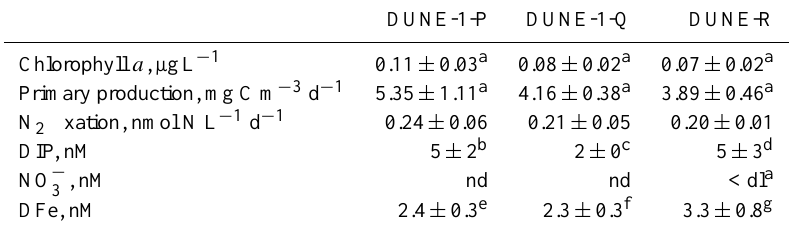
Table 2. Initial biological and chemical properties of seawater before seeding in experiments DUNE-1-P, DUNE-1-Q and DUNE-2-R (aver- age in Dust-meso, Control-meso and Out). DIP: dissolved inorganic phosphorus, dl: detection limit (30nM for NO − chlorophyll a , DIP, NO − and DFe are the mean concentrations at 0.1, 5 and 10m depths. Data for primary production and N 2 fixation are 3 the mean rates at 0.1 and 5m depths for P and Q experiments and at 5m depth for R experiment.